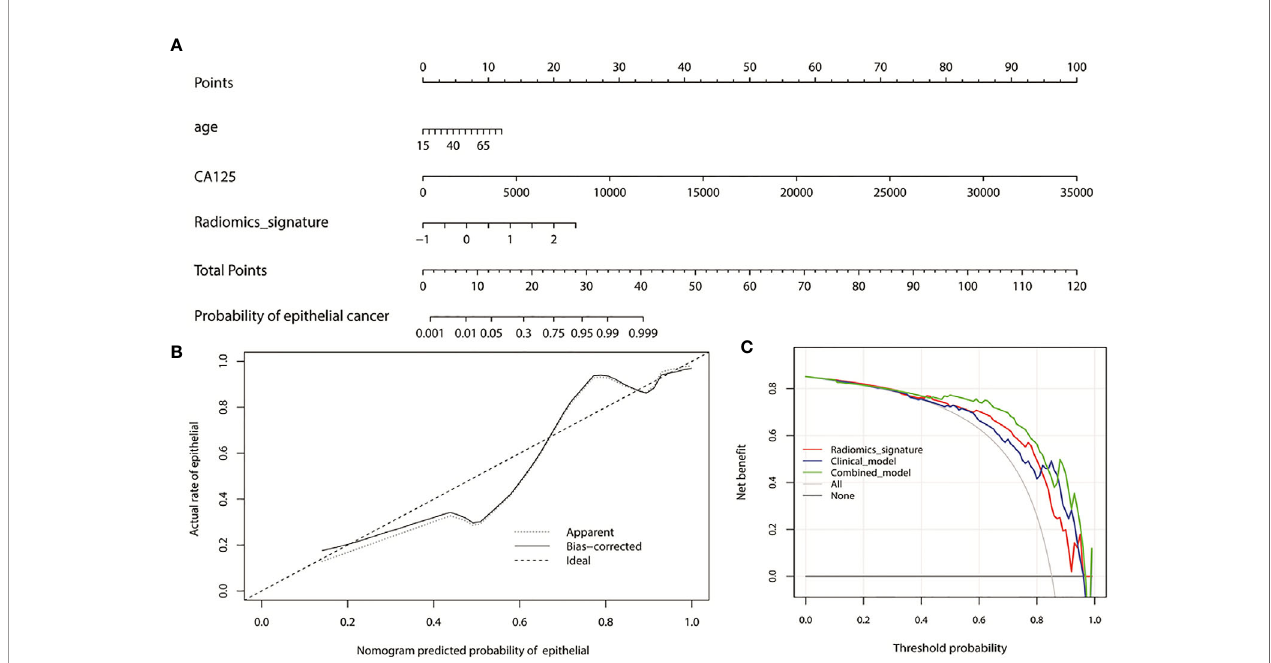
FIGURE 4 | (A) Nomogram for the prediction of histological types. The different values for each variable corresponds to a point at the top of the graph, while the sum of the points for all the variables corresponds to a total point, draw a line from the total points to the bottom line is the probability of epithelial. (B) the calibration curve of the combined model showing the difference between the predicted probability of histological type and the actual probability. The “ Ideal ” line represents the perfect prediction as the predicted probabilities equal to the observed probabilities. The “ Apparent ” curve is the calibration of the entire cohort. The “ Bias-correct ” curve was the calibration created by internal validation of 1000-replicate bootstrap on the entire cohort. (C) the decision curve analysis for the radiomics signature, clinical model, and combined model. On the horizontal axis is the net bene fi t. The threshold probability is on the vertical axis. The gray line represents the assumption that all patients with epithelial OC. The black line represents the assumption that all patients with non-epithelial OC. The red line represents the radiomics signature, blue line and green line represent the clinical model and combined model